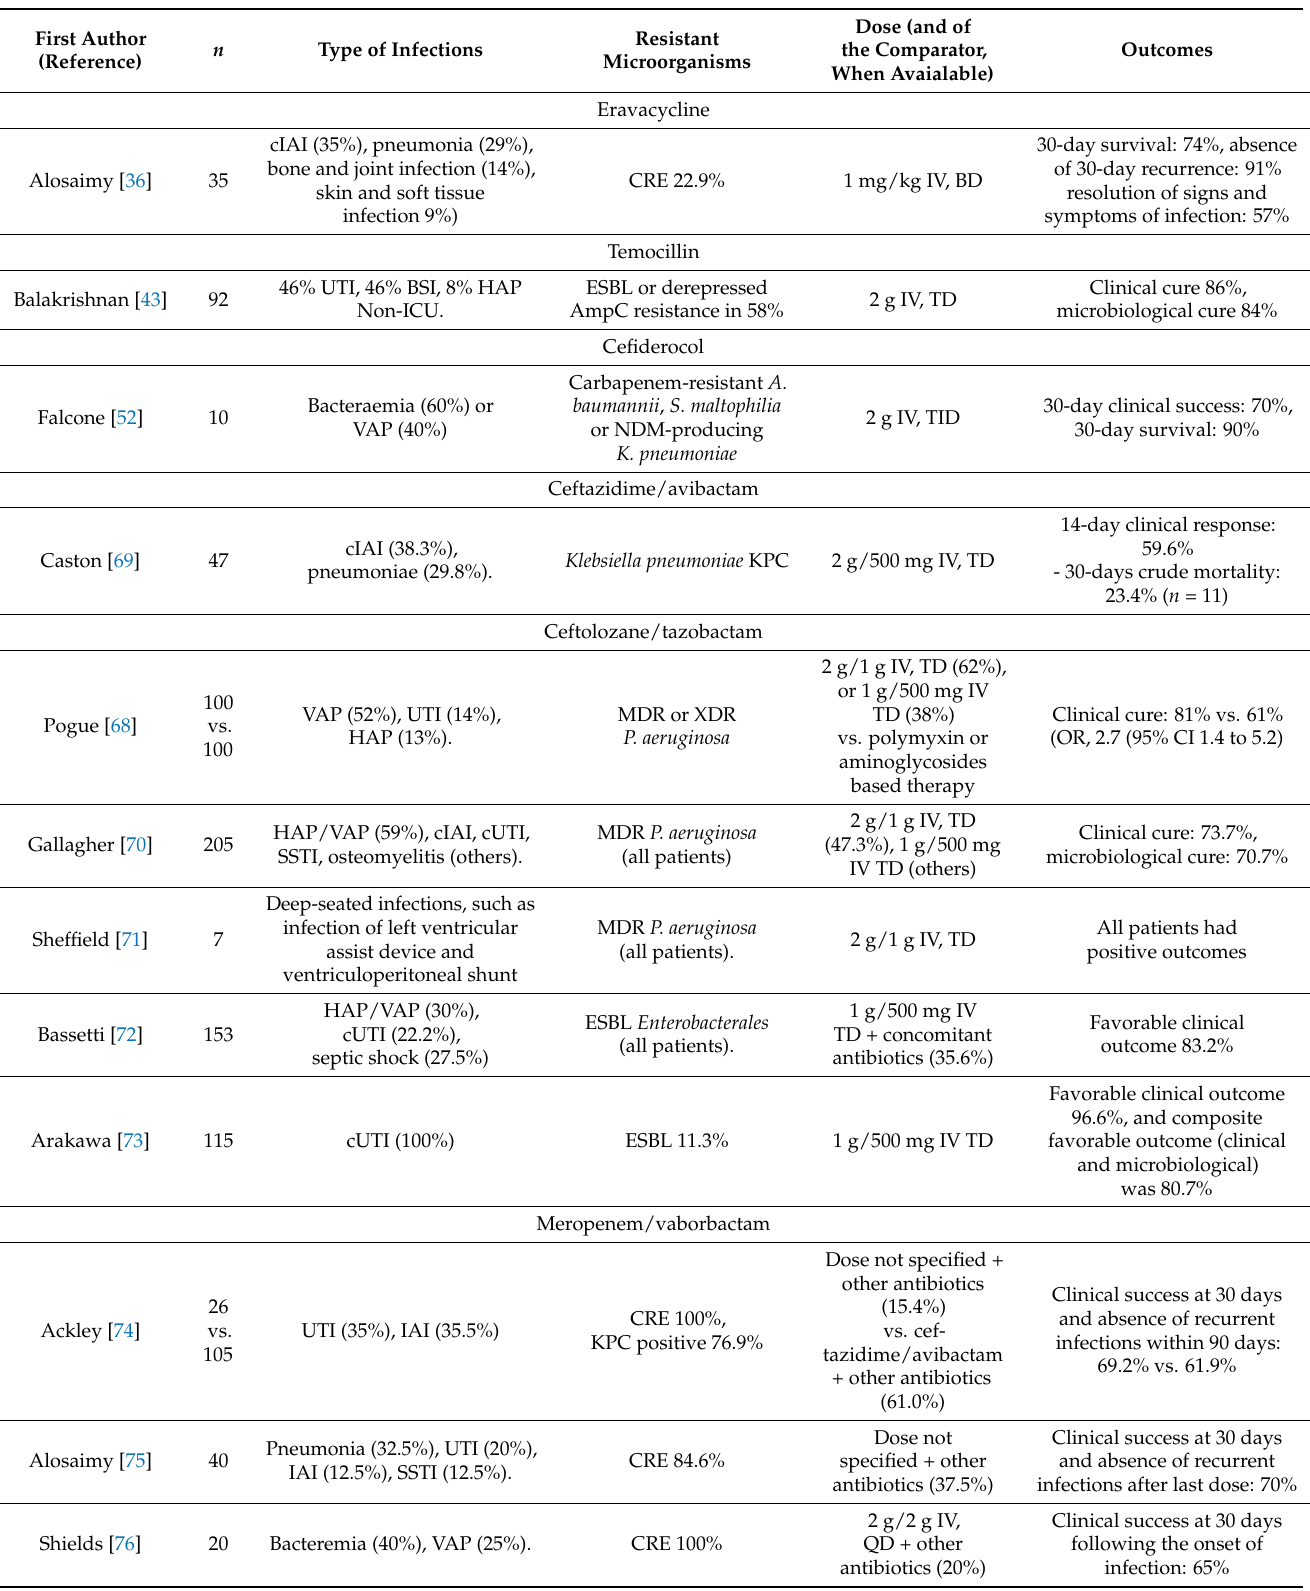
Table 4. Observational and post hoc studies on the new